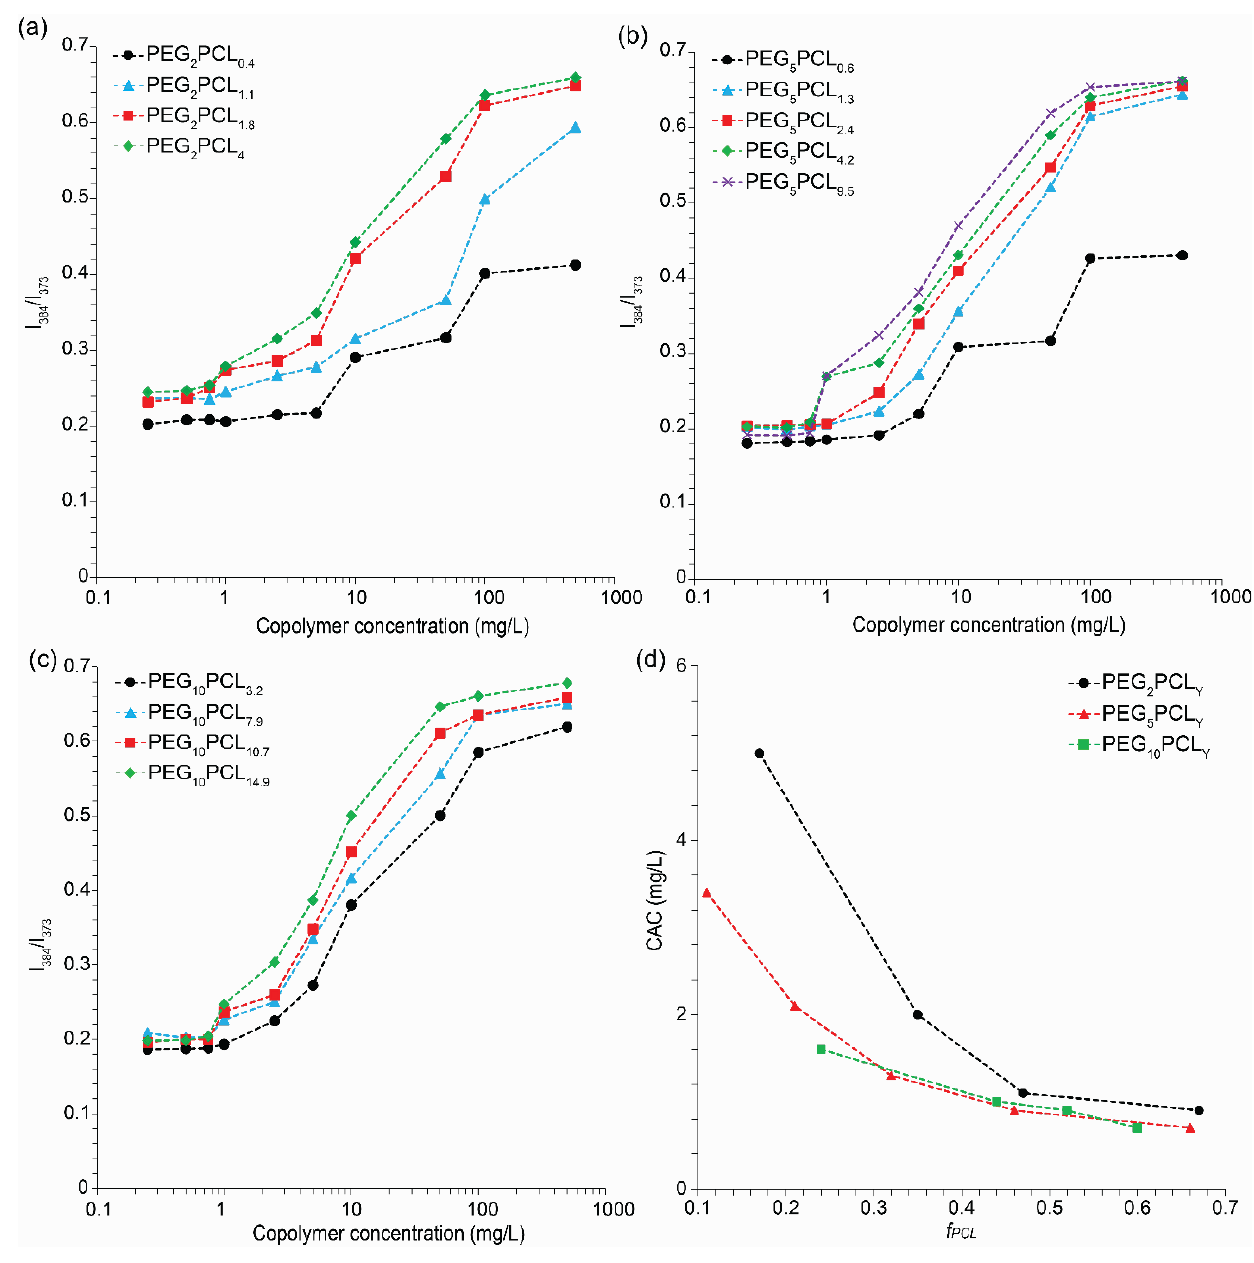
Figure 1. Ratiometric intensity (I 384 /I 372 ) of the pyrene emission as a function of copolymer concen- tration in high-purity water for the ( a ) PEG 2 PCL y , ( b ) PEG 5 PCL y , and ( c ) PEG 10 PCL y copolymer se- ries. ( d ) CAC of the copolymers as a function of f PCL . series. ( d ) CAC of the copolymers as a function of f PCL